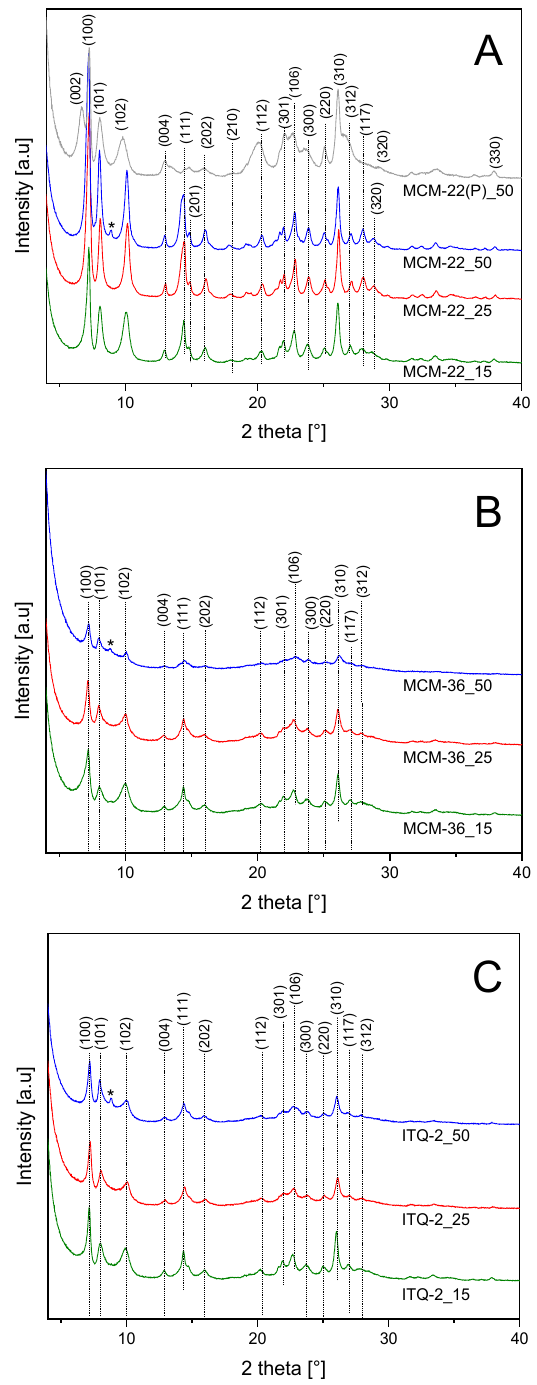
Figure 1. X-ray di ff ractograms of MCM-22 ( A ), MCM-36 ( B ) and ITQ-2 ( C ) zeolites, * additional silica-alumina